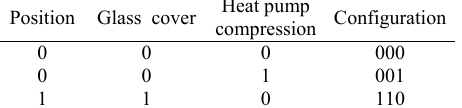
Position Glass cover